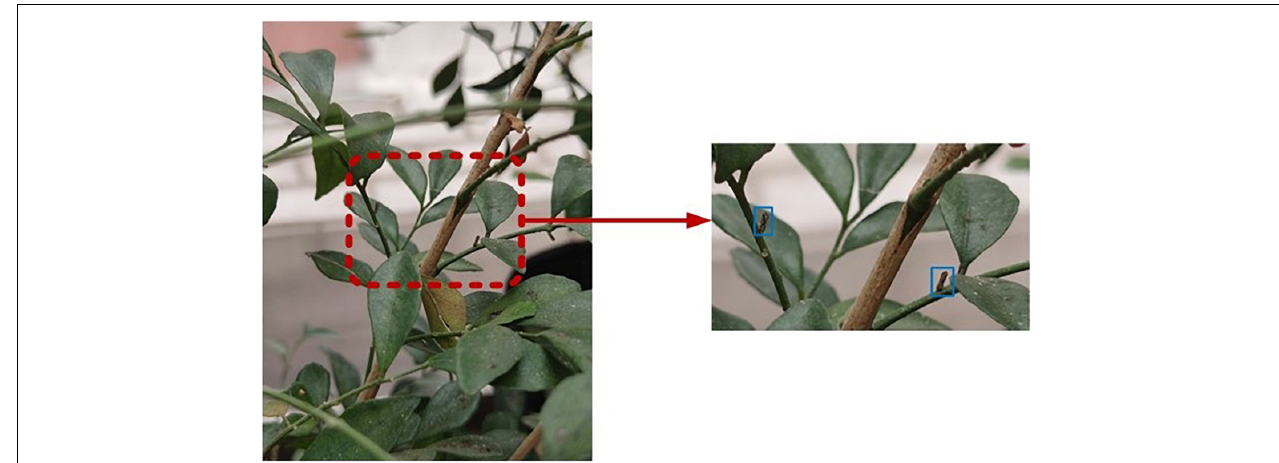
FIGURE 1 | Experimental data. The blue box is used to mark citrus